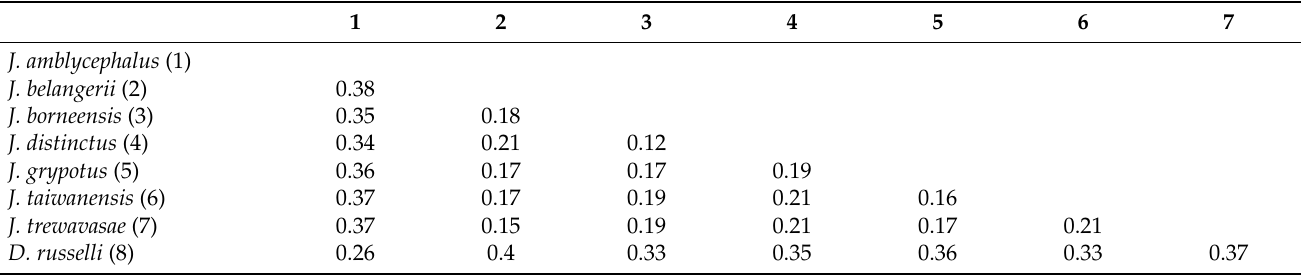
Figure 4. Phylogenetic tree of the Johnius species obtained from the COI gene. The numbers below each branch refer to Bayesian analysis (BA) posterior probability values, and the numbers below each branch and at nodes refer to neighbor-joining (NJ) and maximum likelihood (ML) bootstrap value significances, respectively. Only values above 50% are given. Dendrophysa russelii were used as an outgroup. Table 5. Genetic distances for the COI gene among seven Johnius species from Taiwan and Dendrophysa russelii as an